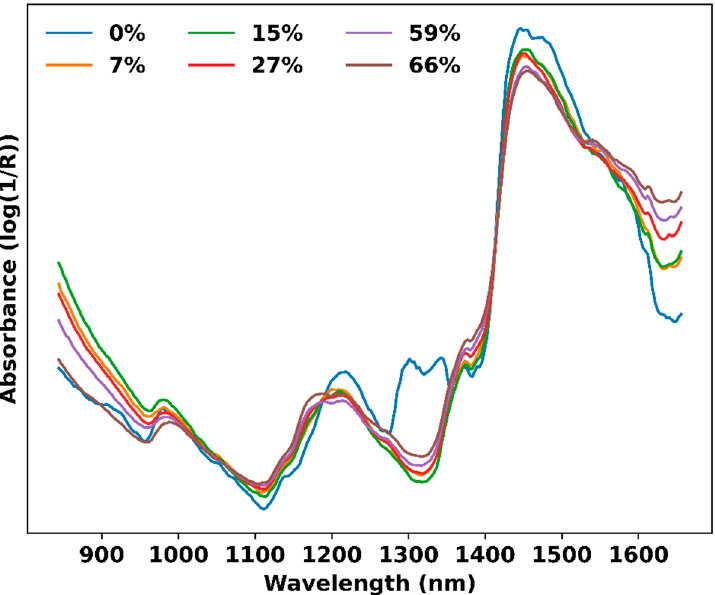
Figure 4. Overlay of selected NIR spectra of SorCA-treated wood after MSC pre-treatment, measured in the tangential direction. Each curve corresponds to one WPG value.